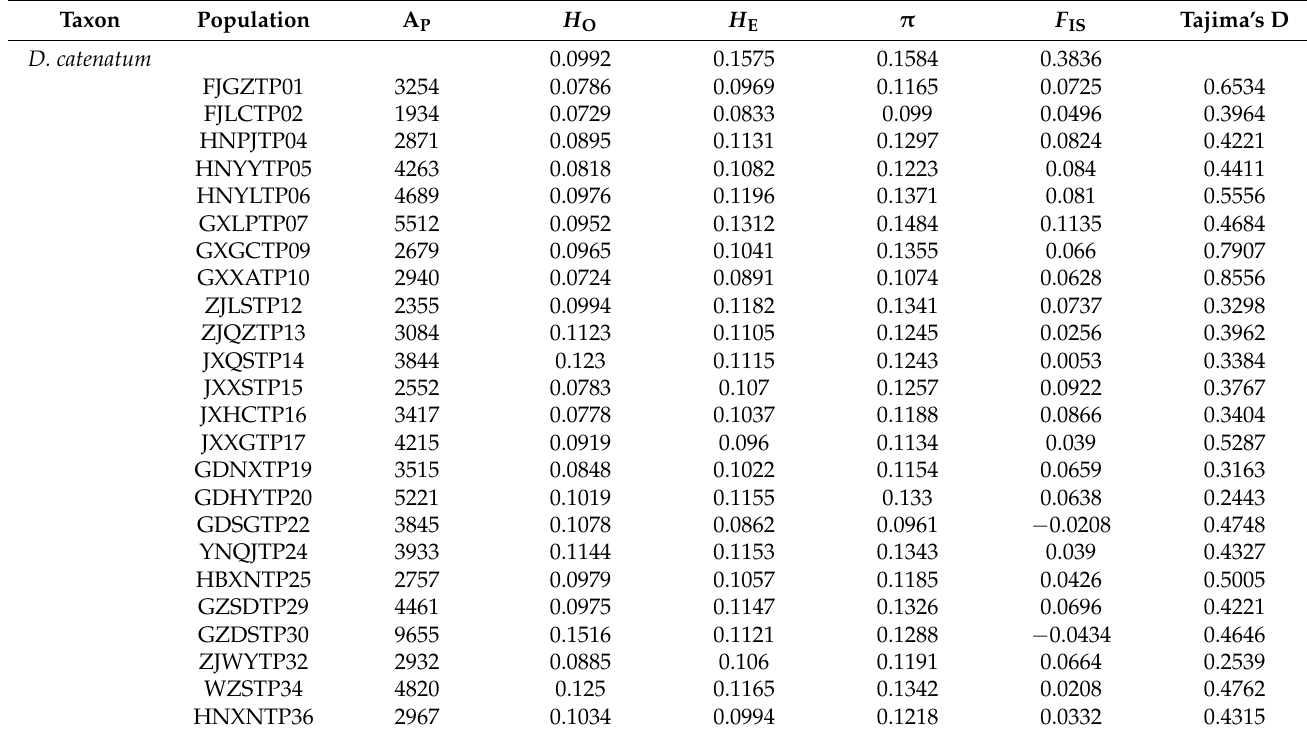
Table 2. The statistical values of genetic diversity within the populations from variants and all of the positions data. (A P , private allele number; H O , observed heterozygosity; H E , expected heterozygosity; π , nucleotide diversity; F IS , inbreeding coefficient of an individual relative to the